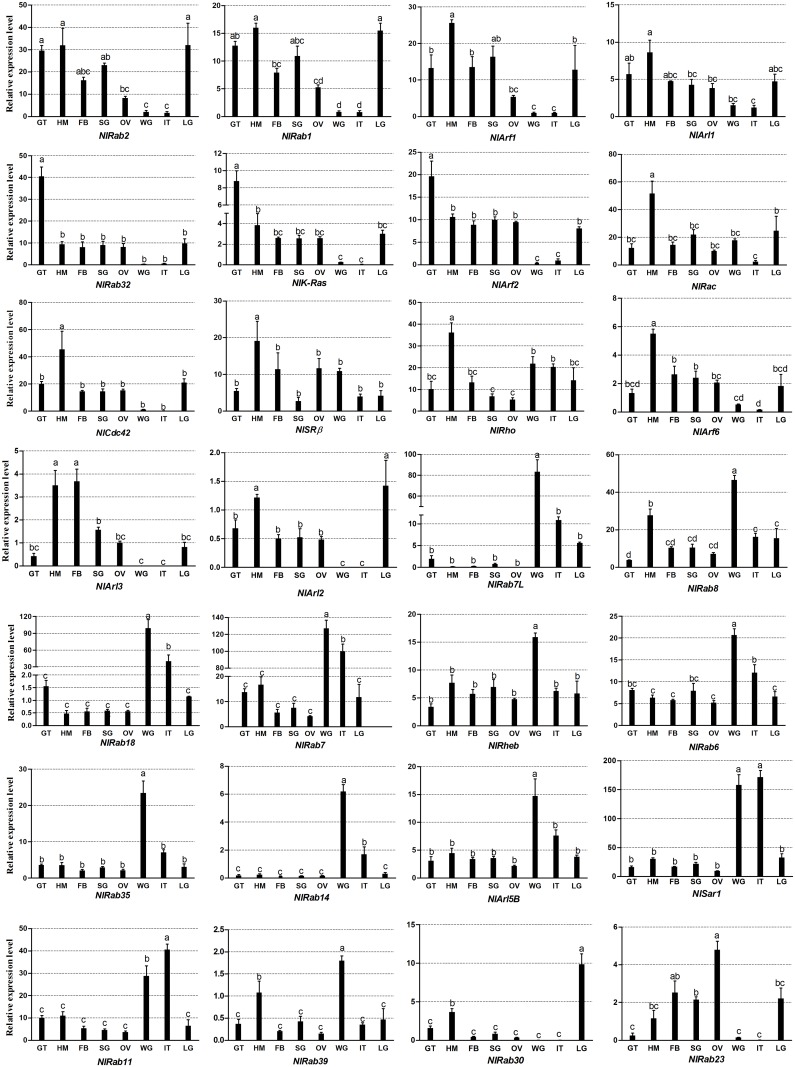
Tissue expression patterns of N. lugens genes encoding RSGs.Total RNA was extracted from the salivary gland (SG), gut (GT), fat body(FB), ovary(OV), hemolymph(HM), integument(IT), leg(LG) and wing (WG). Three biological replications (mean ± SE) were carried out for each gene based on independent samples and relative value for the expression level of target gene was calculated by the equation Y = 10 (Ct internal- Ct target)/3 x100%, using the geometric mean of 18S rRNA and β-actin as internal control. Different letters indicate significant differences among different tissues by Duncan’s multiple range test at P < 0.01.